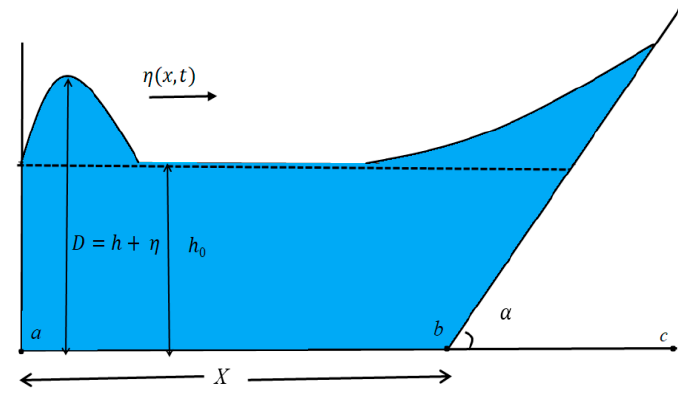
Figure 1. Bathymetry sketch of numerical